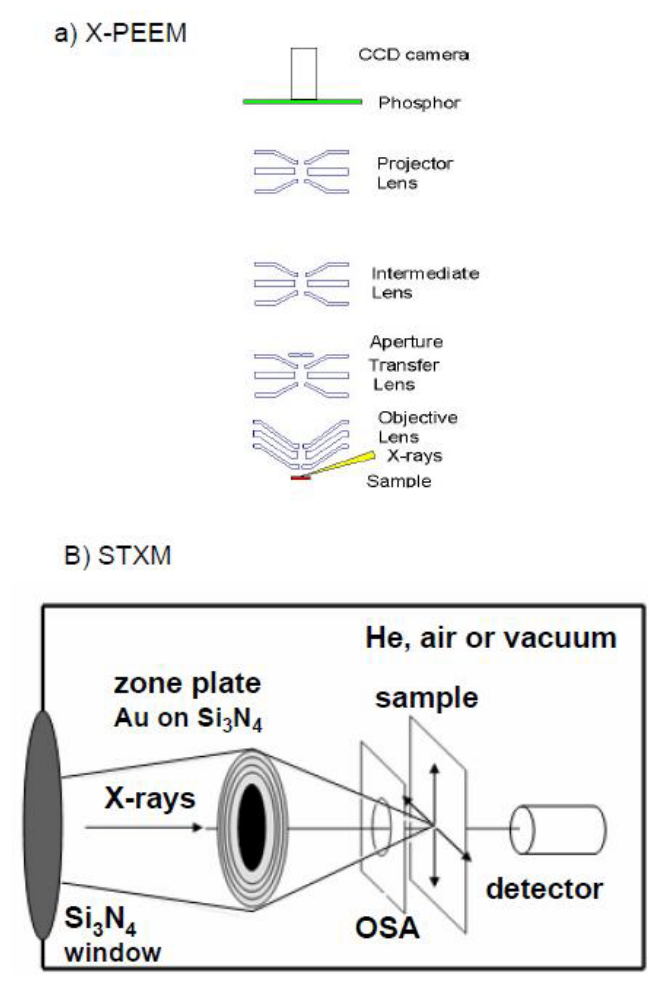
Figure 1 : Schematic of the optics in (a) ALS PEEM-2 (figure courtesy of Andreas Scholl, ALS, LBNL.) and (b)